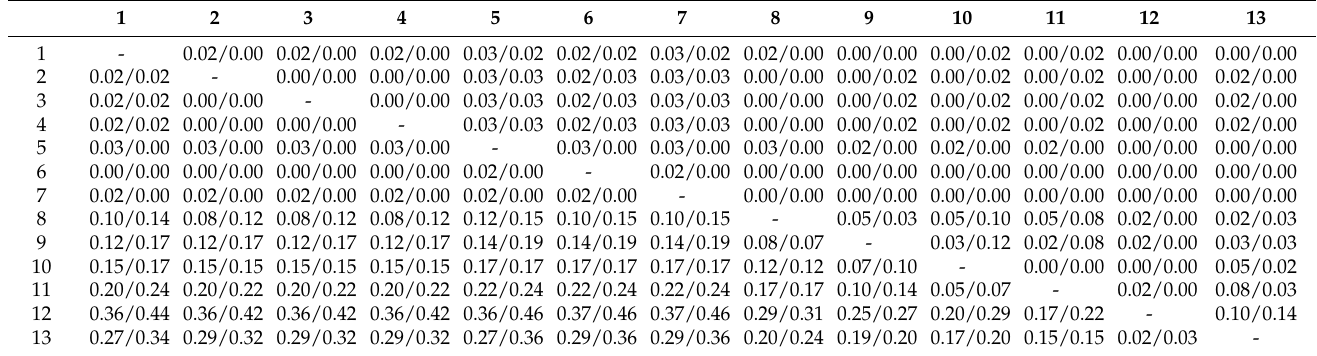
Table 2. Probabilities of disconfirmatory responses for counting and arithmetic concepts by